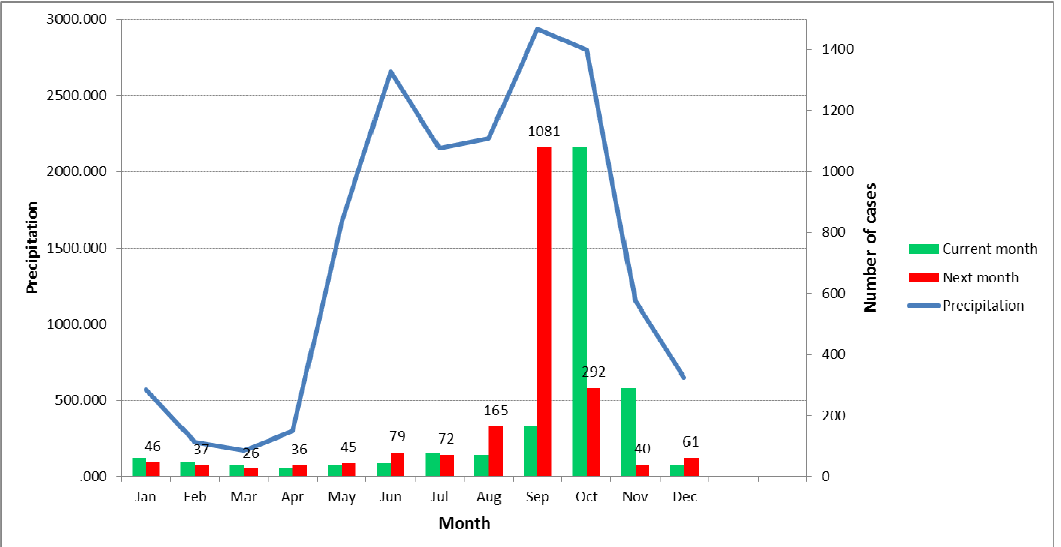
Figure 6. Annual rain pattern and leptospirosis cases distribution in the current and next month, Nicaragua,